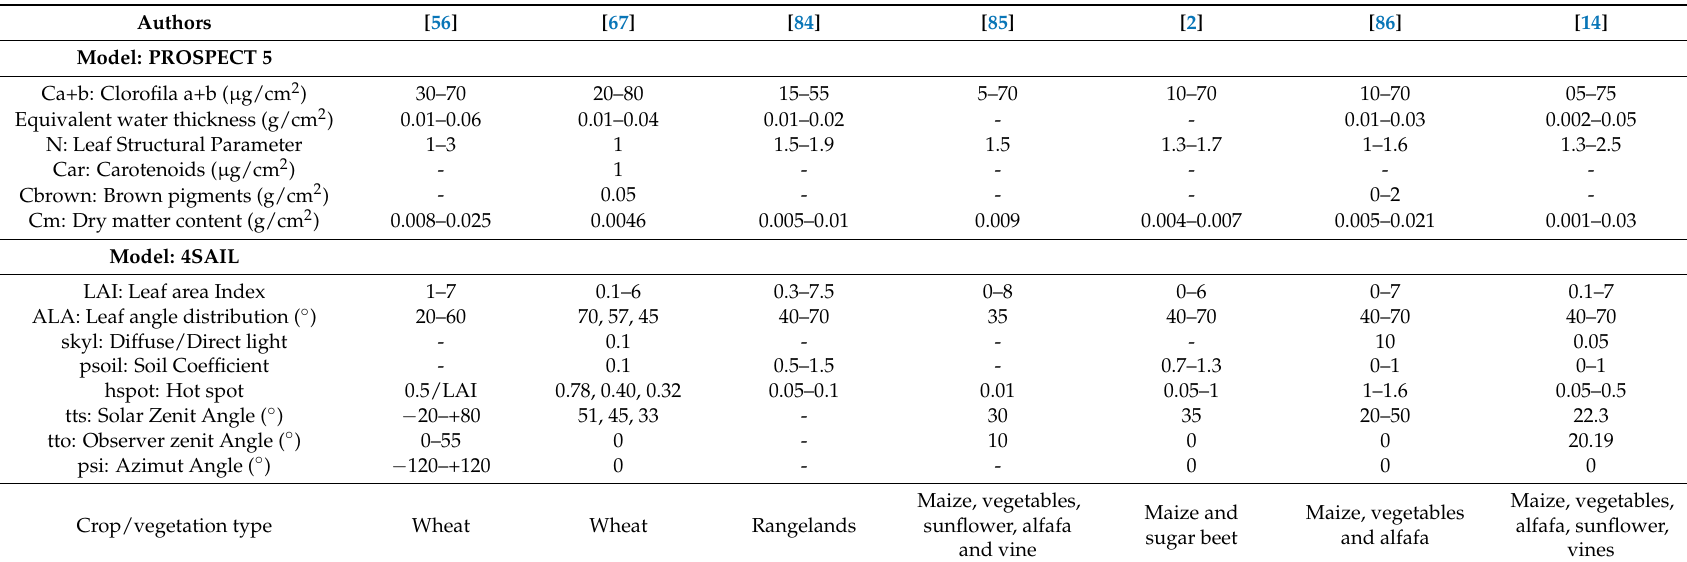
Table A1. Summary of PROSPECT and PROSAIL parameters as used in different